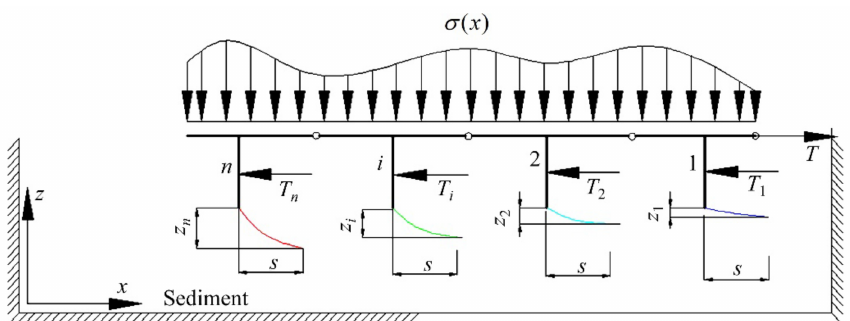
Figure 6. Simplified model of tracked miner’s motion.